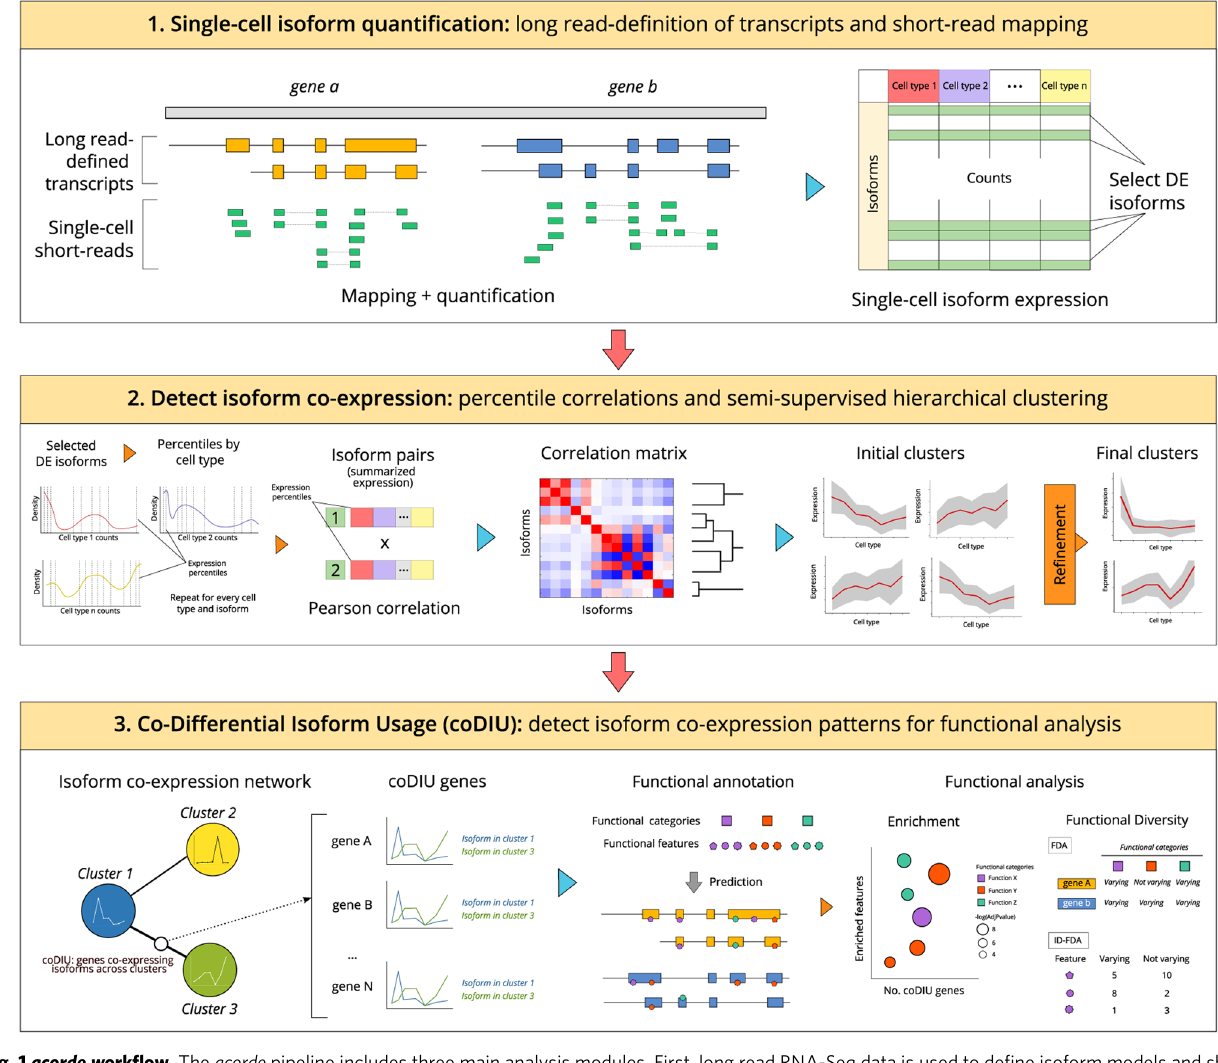
Fig. 1 acorde w ork fl ow. The acorde pipeline includes three main analysis modules. First, long read RNA-Seq data is used to de fi ne isoform models and short, single-cell RNA-Seq reads are mapped to the long read-generated transcriptome. Isoform are then tested for multi-group differential expression and those that are signi fi cantly DE in at least one of the cell types are selected. Next, percentile correlations are computed to cluster isoforms with similar expression patterns across cell types. Finally, gene pairs are tested for co-differential isoform usage, detecting genes that form co-expression relationships for subsequent functional